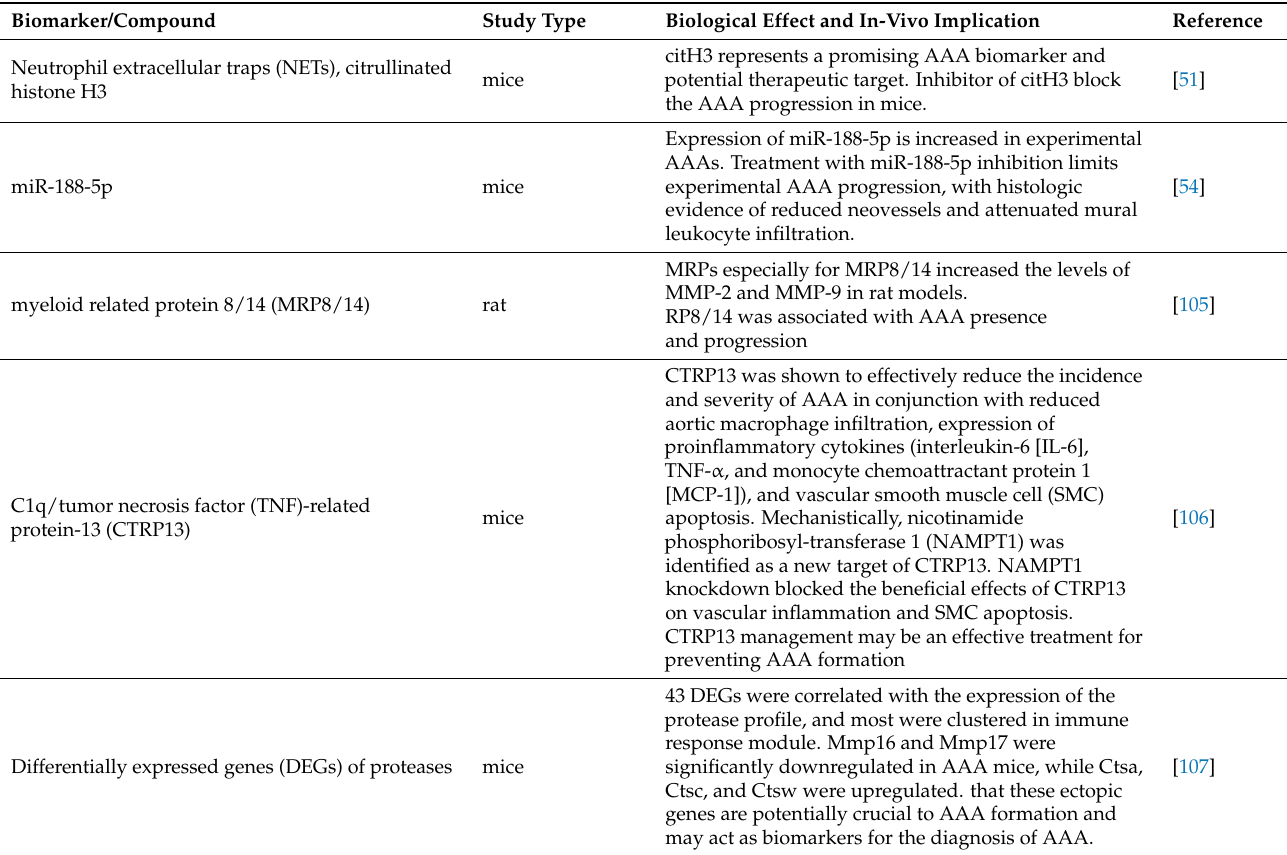
Table 1. Potential new biomarkers from recent pre-clinical